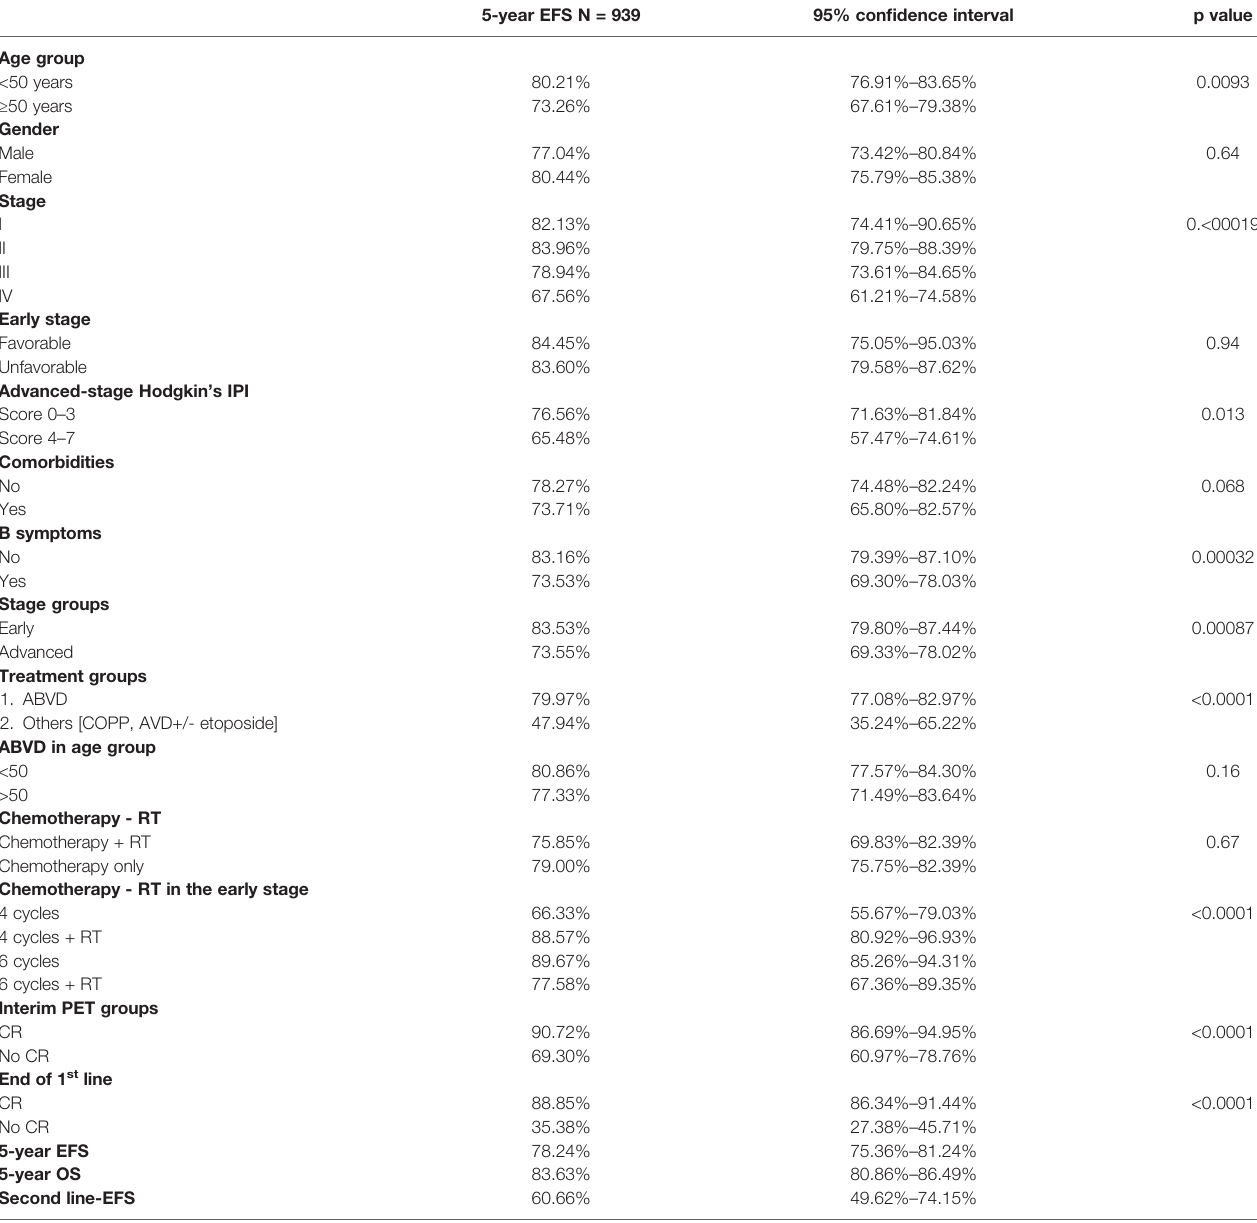
TABLE 2 | 5-year outcomes of classical Hodgkin